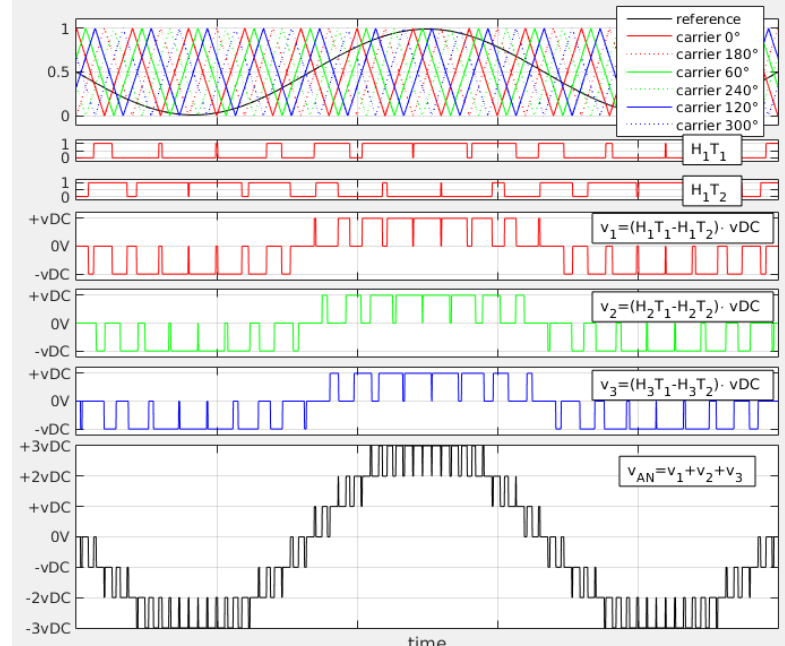
Figure 6. Graphical procedure for the PWM generation through comparison with phase-shifted